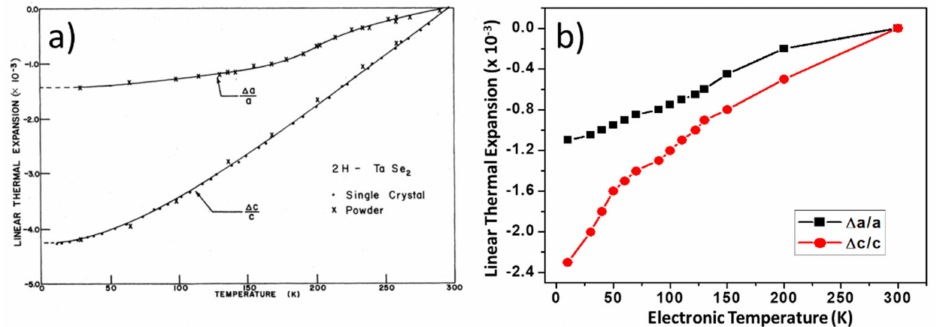
Figure 3. Comparison between ( a ) experimental [97] and ( b ) DFT [108] lattice expansion for TaSe 2 when the temperature dependence is introduced in the DFT modeling solely through changes in the electronic temperature. Reprinted figure with permissions from Reference [97]. Copyright 1978 by the American Physical Society. Reprinted figure with permission from Reference [108]. Copyright 2019 by the American Physical Society.